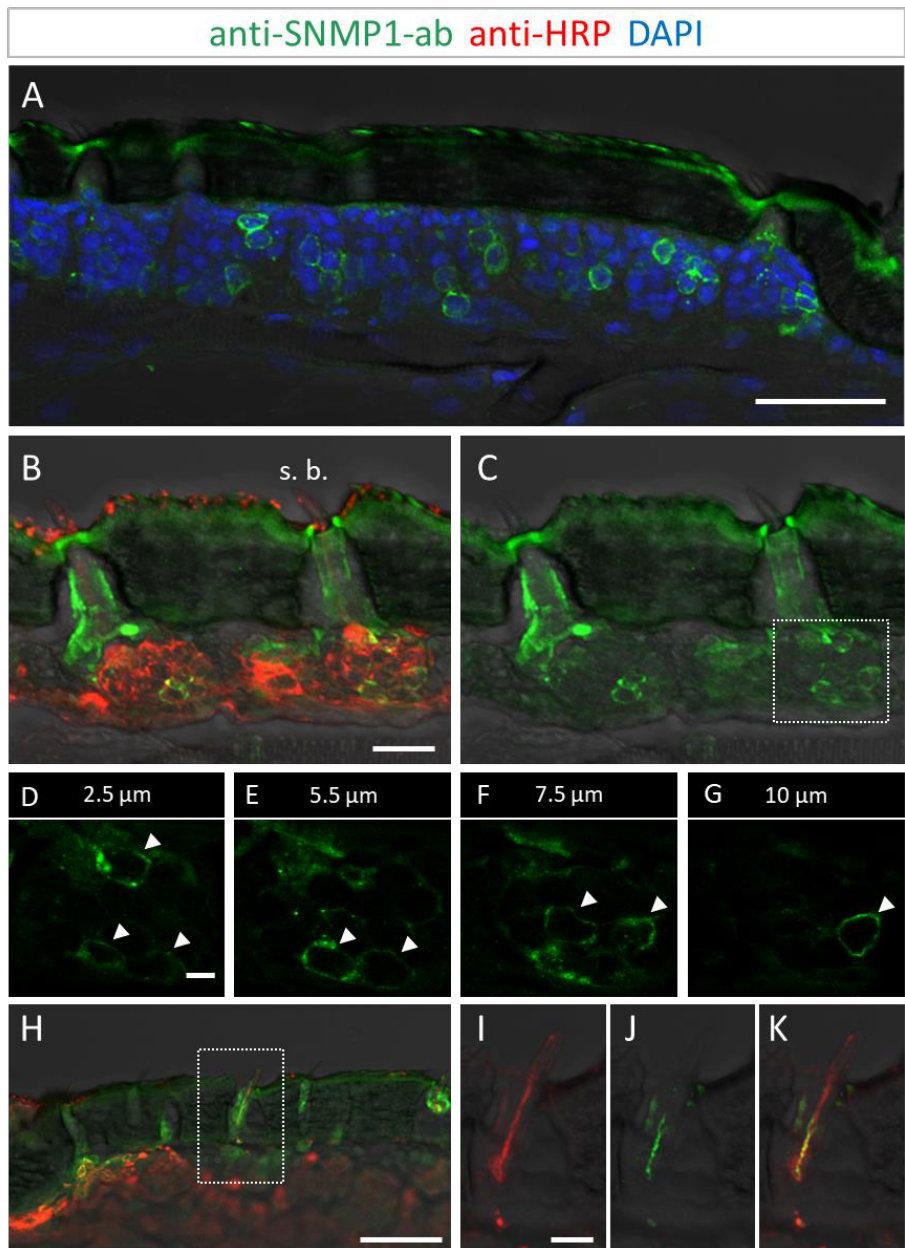
Figure 2. SNMP1 expression in a subset of OSNs in the antenna of S. gregaria . SNMP1-positive cells were visualized by FIHC in longitudinal sections using anti-SNMP1-ab (green). Neurons were identified by an anti-HRP-antibody (red) and nuclei were stained with DAPI (blue). ( A ) Distribution of multiple SNMP1 cells in an antennal segment. ( B , C ) Expression of SNMP1 (green channel) in a fraction of the OSNs (red channel) of basiconic sensilla (s. b.). ( D – G ) Higher magnifications of the OSN cluster boxed in ( C ) shown at different optical planes of a confocal z-stack; arrows denote SNMP1-positive neurons. ( H – K ) Localization of SNMP1 in OSN dendrites of a basiconic sensillum. ( I – K ) Higher magnifications of the area boxed in ( H ) showing the red ( I , OSN) and green ( J , SNMP1) channels separately or overlaid ( K ). The transmitted light channel was overlaid with fluorescent channels in ( A – C , H – K ). Scale bars: ( A,H ) = 50 μm; ( B ) = 20 μm; ( D ) and ( I ) = 5 µm.